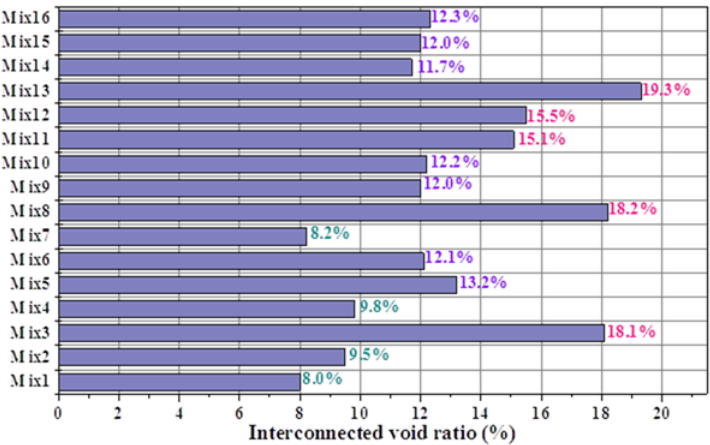
Figure 11. The interconnected void ratios of porous mortar.